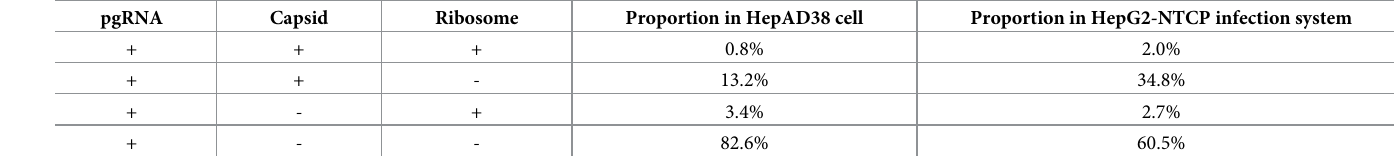
Table 1. Distribution ratio of different forms of pgRNA in HepAD38 cell and in HepG2-NTCP infection system.